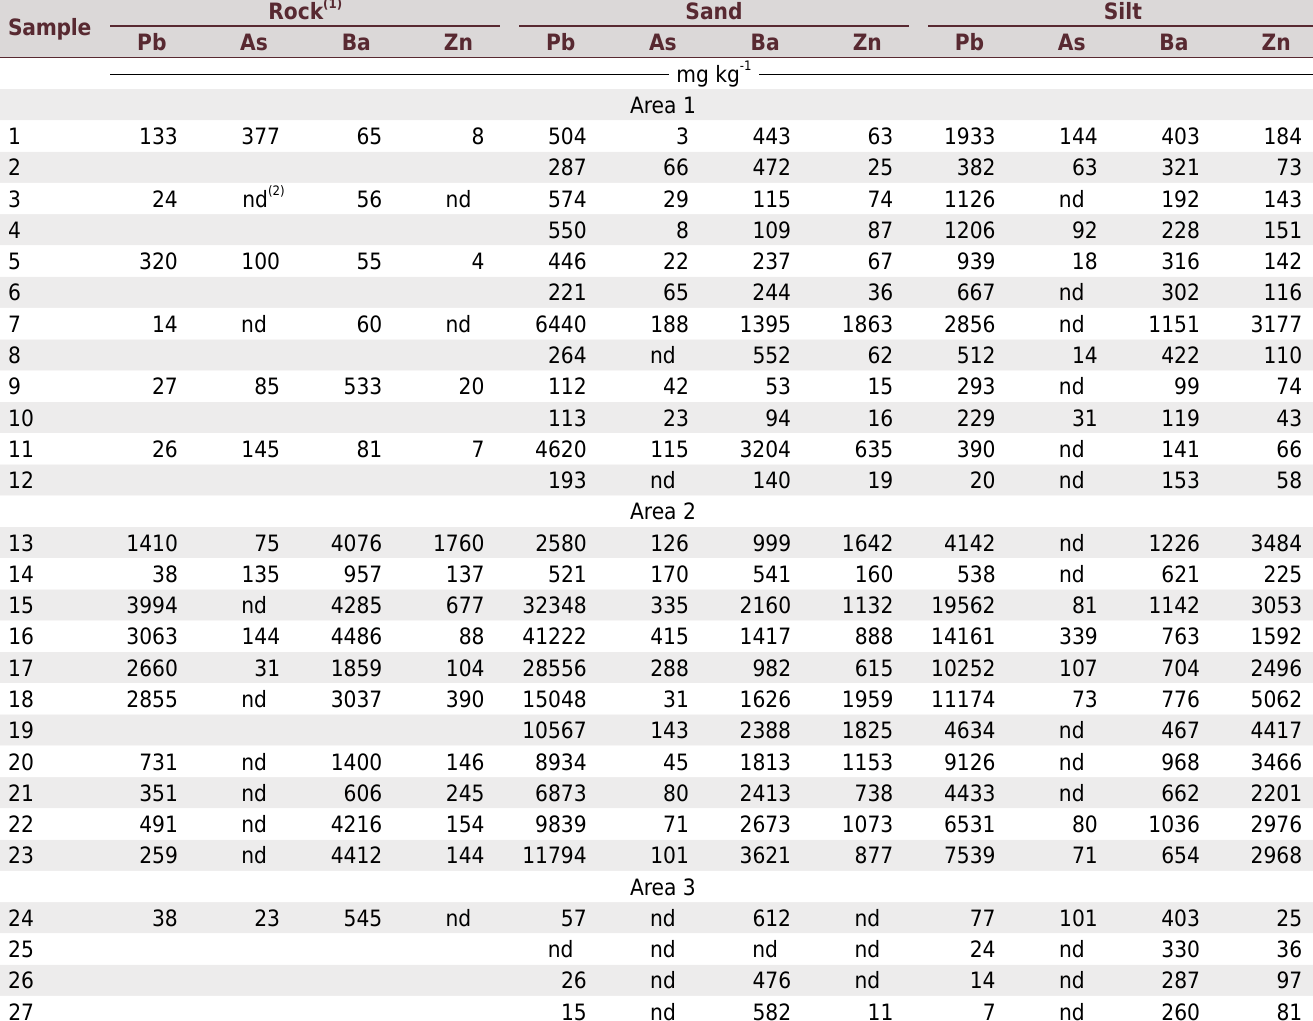
Table 2. Total contents of Pb, As, Ba, Zn, and Cu in sand and silt fractions of soils in areas 1, 2, and 3